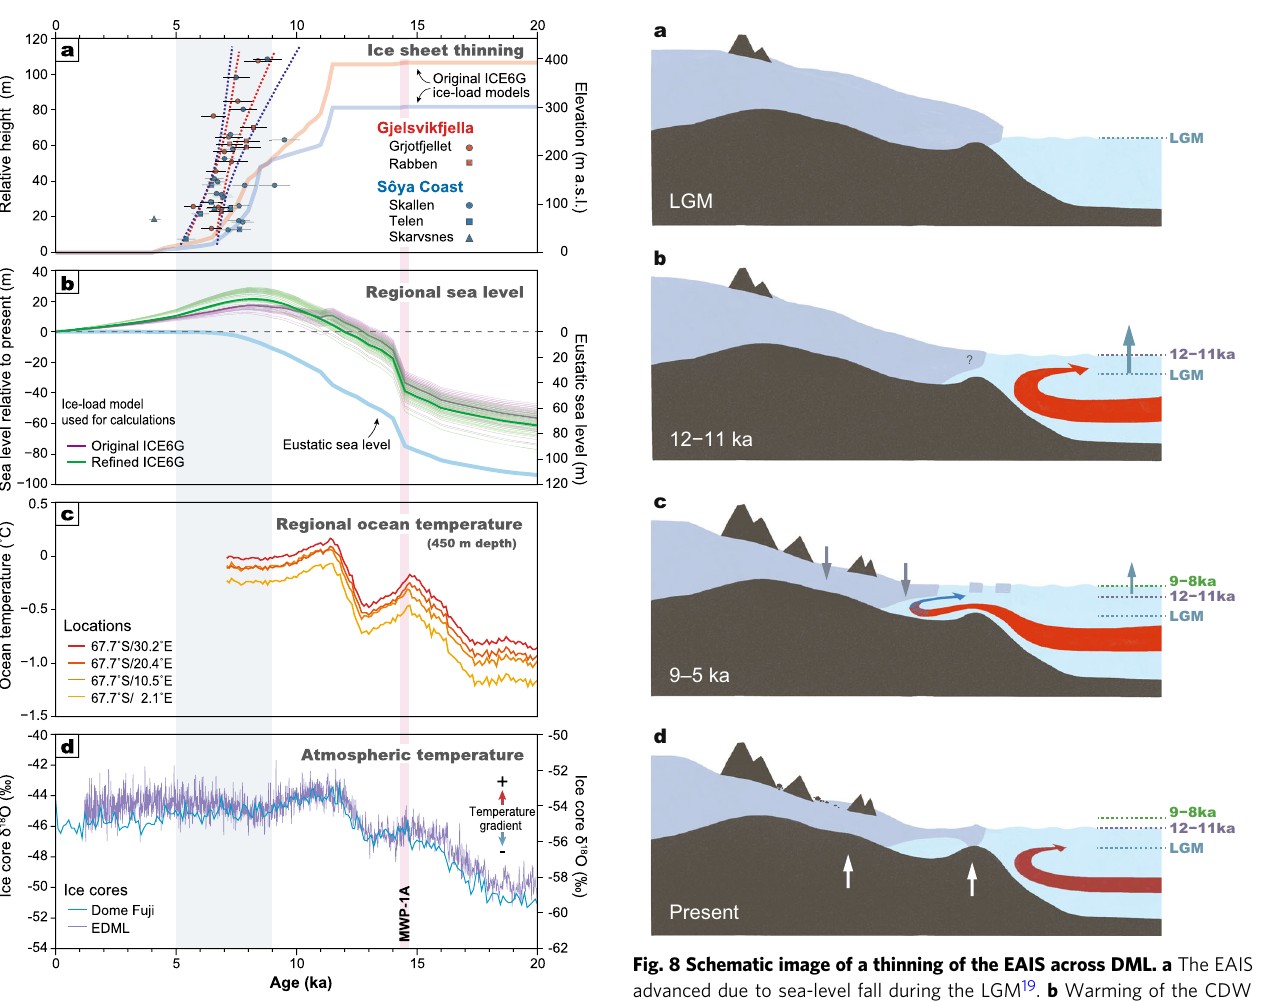
Fig. 7 Post-LGM ice-sheet thinning in Droning Maud Land compared with paleoclimatic proxies from 20 ka to present. a The 95% con fi dence intervals of ice surface lowering in Gjelsvikfjella (red, left axis) and the Sôya Coast (blue, right axis) from Fig. 6, and original ICE6G ice-load models for Gjelsvikfjella and the Sôya Coast. All uncertainties are reported as 1 σ external errors. b Relative sea levels at 0 ˚ E, 71.5 ˚ S calculated by an original ICE6G ice-load model 42 and its re fi ned version, compared with the eustatic sea level 42 . The thin lines are relative sea levels based on different earth models (applicable range for upper and lower mantle viscosity), and the bold line corresponds to the best model 76 (see “ Methods ” ). c Modeled Ocean temperatures at 450 m water depth 40 , extracted for several locations offshore of DML (see Fig. 1b). A depth of 450 m is selected because this is the typical depth where CDW is located 37 . d δ 18 O record from Dome Fuji 38 (blue, right axis) and EDML 39 (purple, left axis) ice cores using the Antarctic Ice Core Chronology 2012 84 . The gray and red vertical bars represent the deglaciation phase used for re fi ning the GIA ice load model, and the timing of Meltwater Pulse 1A (MWP-1A) 34 , respectively.